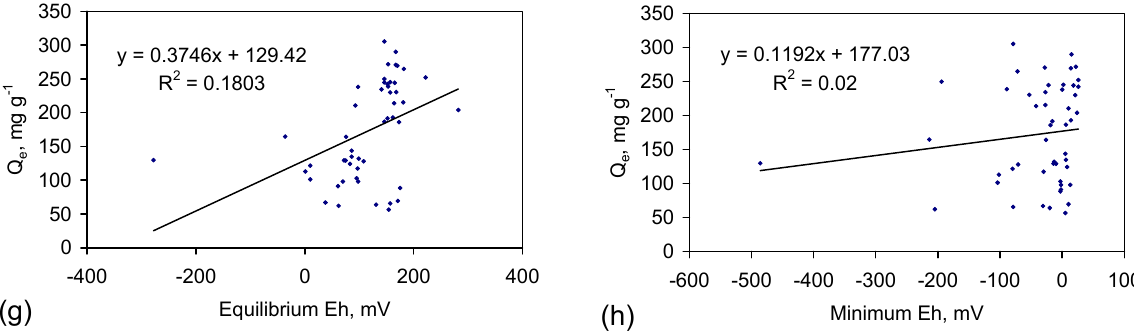
Figure 8. Observed Relationships: between desalination ( Q e ) and: ( a ) Desalination ( Q e ) vs. C 0 ; ( b ) Desalination ( Q e ) vs. ZVM TP concentration; ( c ) Desalination ( Q e ) vs. Equilibrium pH; ( d ) Desalination ( Q e ) vs. Maximum pH; ( e ) ZVM TP concentration vs. Equilibrium pH; ( f ) ZVM TP concentration vs. Maximum pH; ( g ) Desalination ( Q e ) vs. Equilibrium Eh; ( h